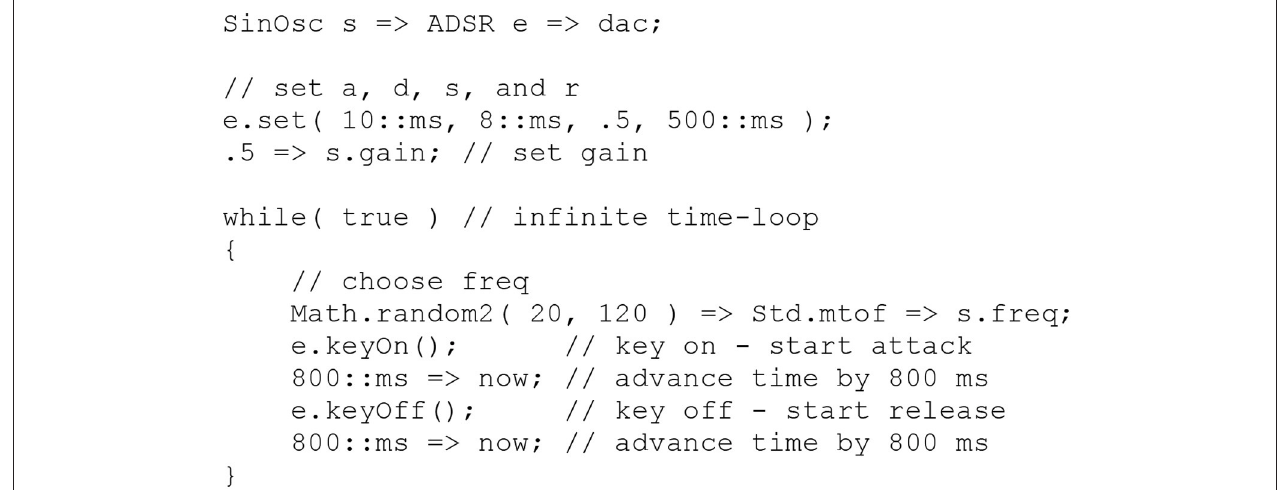
FIGURE 8 | ChucK example code. (based on http://chuck.cs.princeton.edu/doc/examples/basic/adsr.ck).